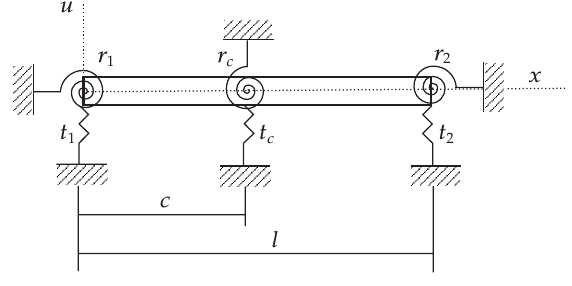
Figure 2.1 . Vibrating system under